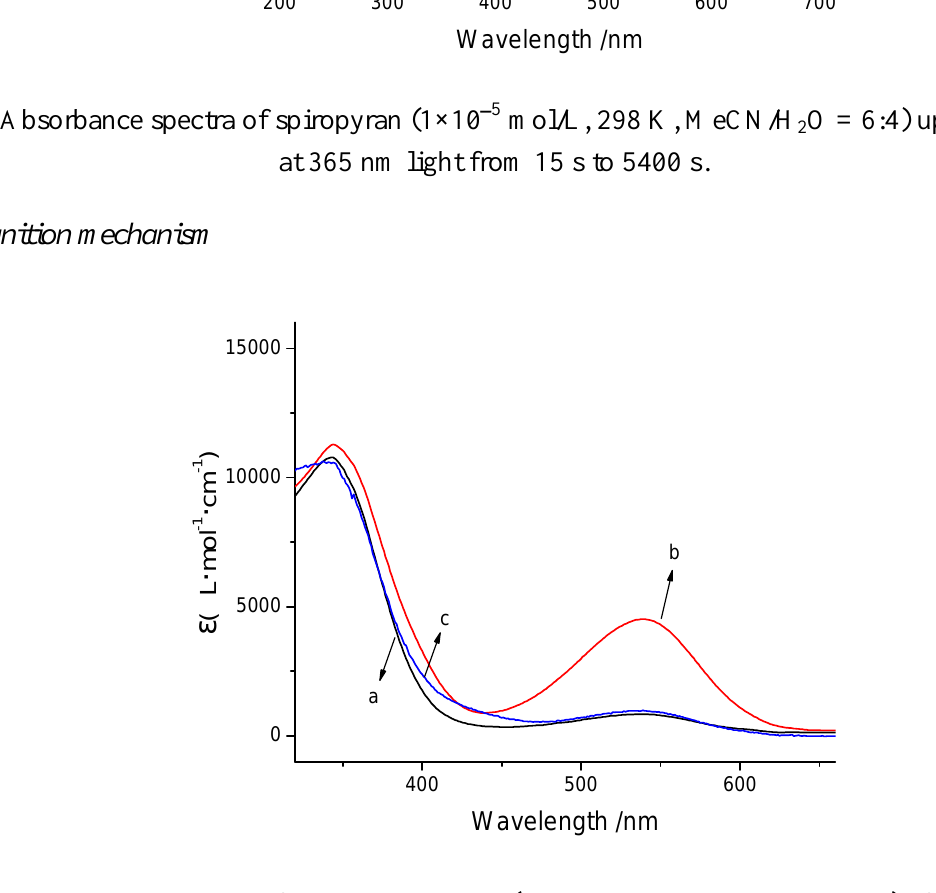
O = 6:4, V/V) after irradiation Figure 2. Absorbance spectra of spiropyran sensor (298 K, MeCN/H 2 for 10 min at 365 nm light with addition of Al 3+ (c), without addition of Al 3+ (b), and with addition of Al 3+ after irradiation by visible light for 10 min